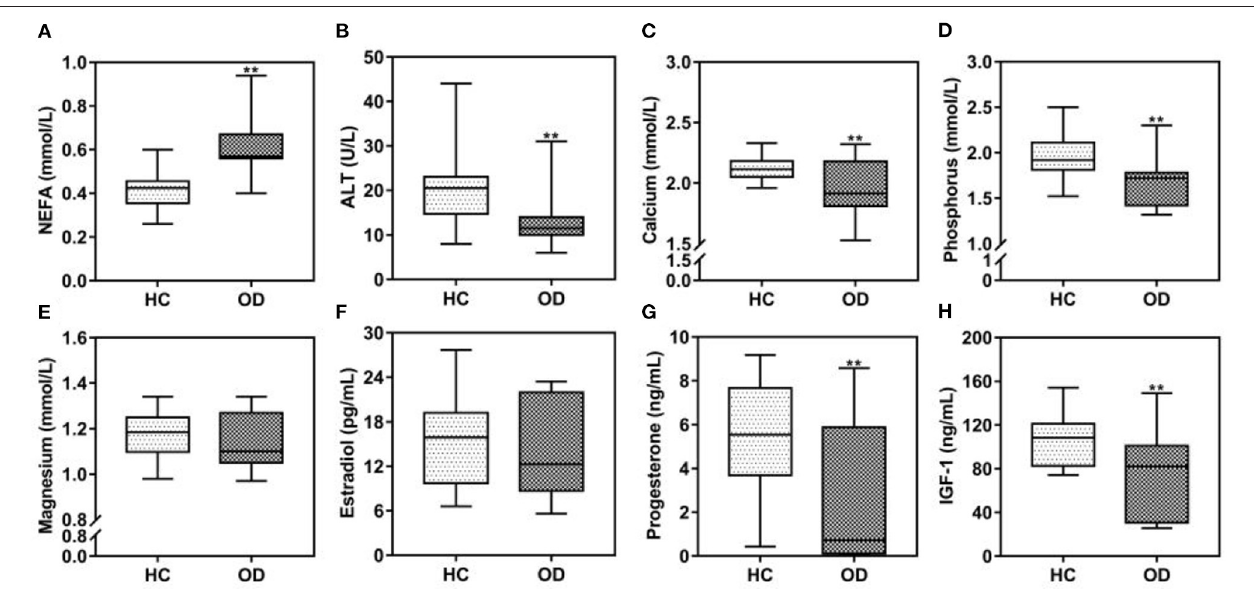
FIGURE 3 | (A–H) Comparison of plasma biochemical indicators between the ovarian diseases (OD, n = 54) group and healthy control (HC, n = 22) group at 3 weeks postpartum. Note: ** P < 0.01 vs. healthy control group. NEFA, non-esterified fatty acids; ALT, alanine aminotransferase; IGF-1, insulin-like growth factor 1.